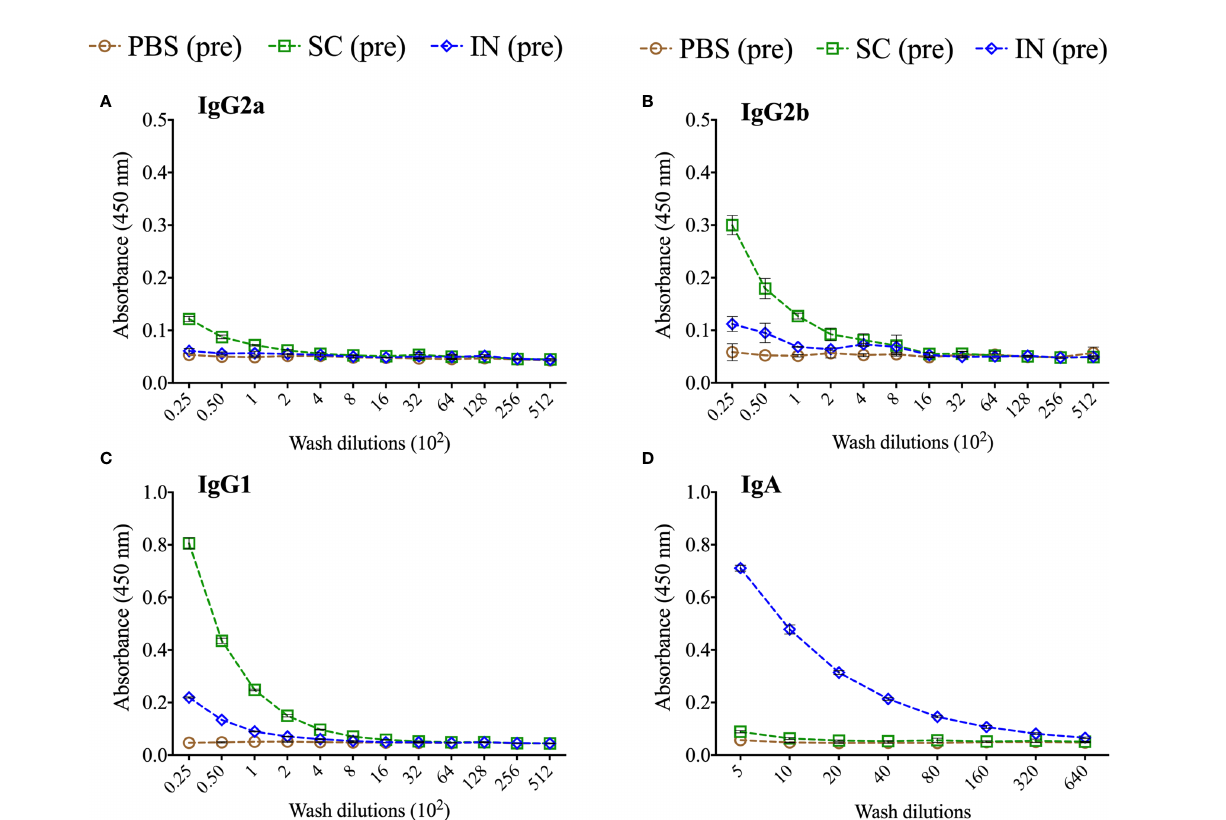
FIGURE 6 | Production of antigen-speci fi c mucosal antibodies in immunized mice. Groups of mice were immunized three times at two-week intervals with either PBS or PLGA-rMOMP via the SC or IN routes. Pooled mucosal washes per group were diluted at a two-fold serial dilution to determine by ELISA the endpoint